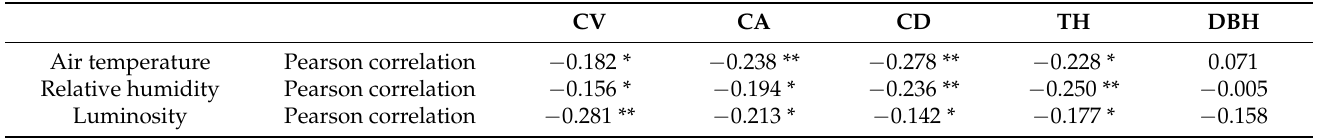
Table 3. Correlation analysis between morphological structure characteristics of street trees and microclimate factors.